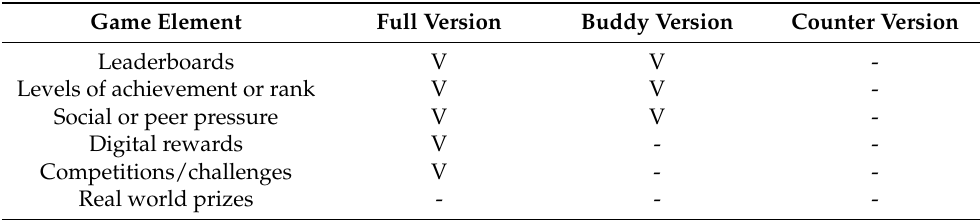
Table 1. Game elements included in each version of the APP, based on the list proposed by Lister and colleagues